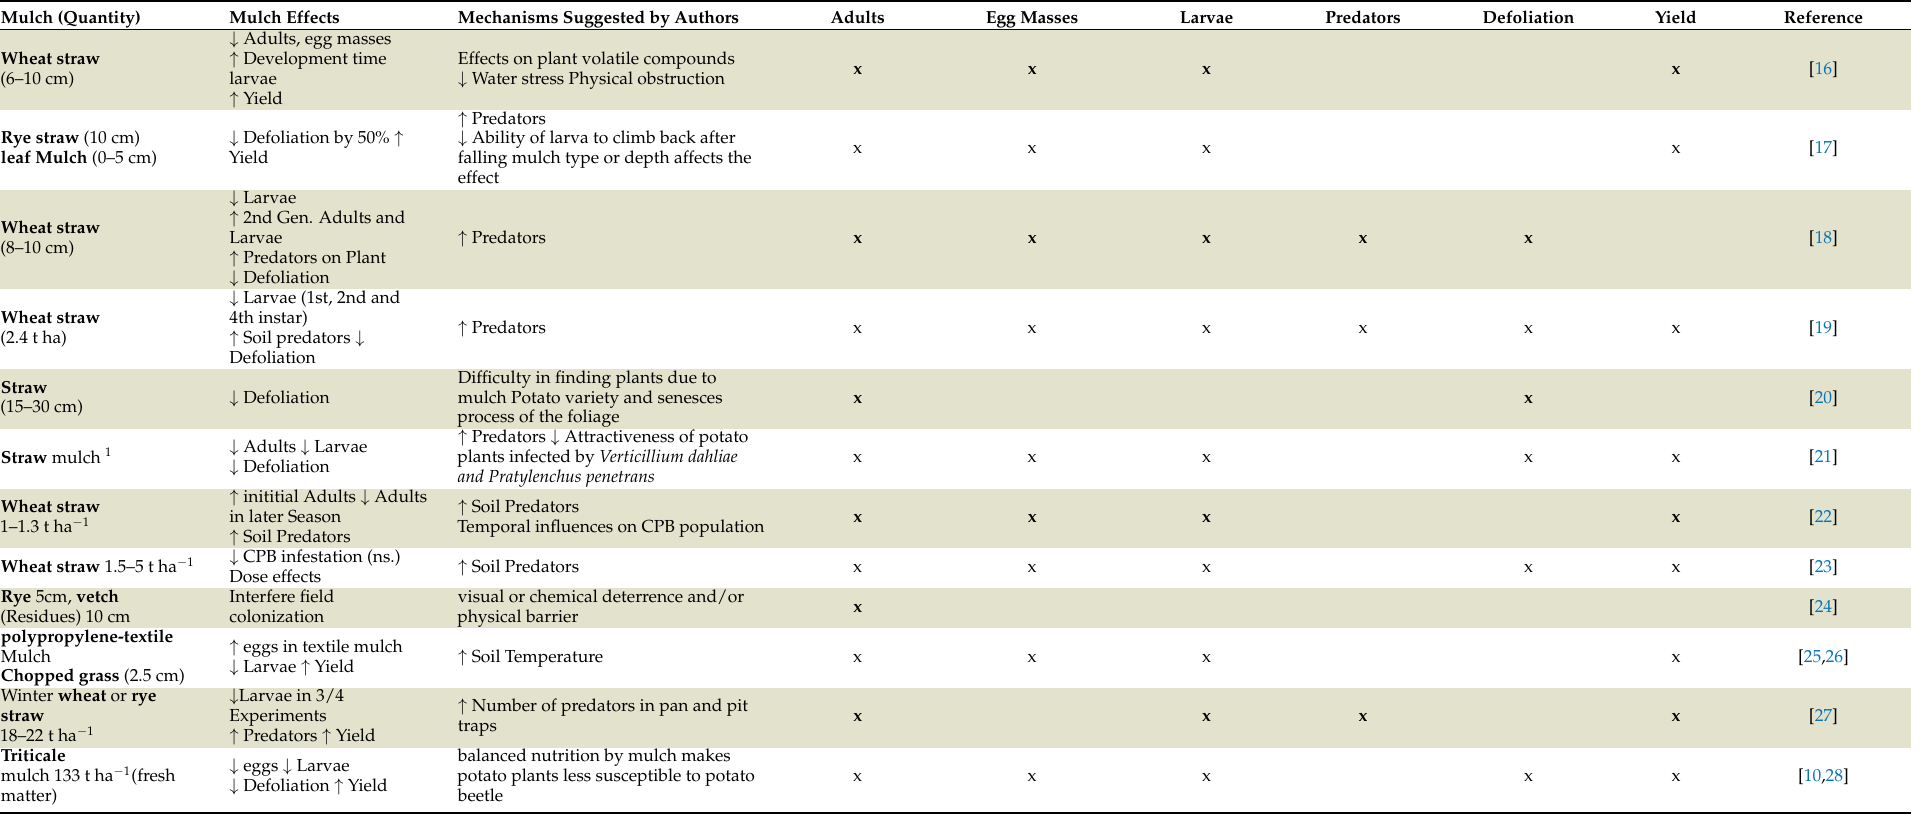
Table 1. Summary of published results of mulch applications on potato beetle life stages. Arrows indicate increases ( ↑ ) or decreases ( ↓ ). In the columns, x indicates the CPB stages investigated in the